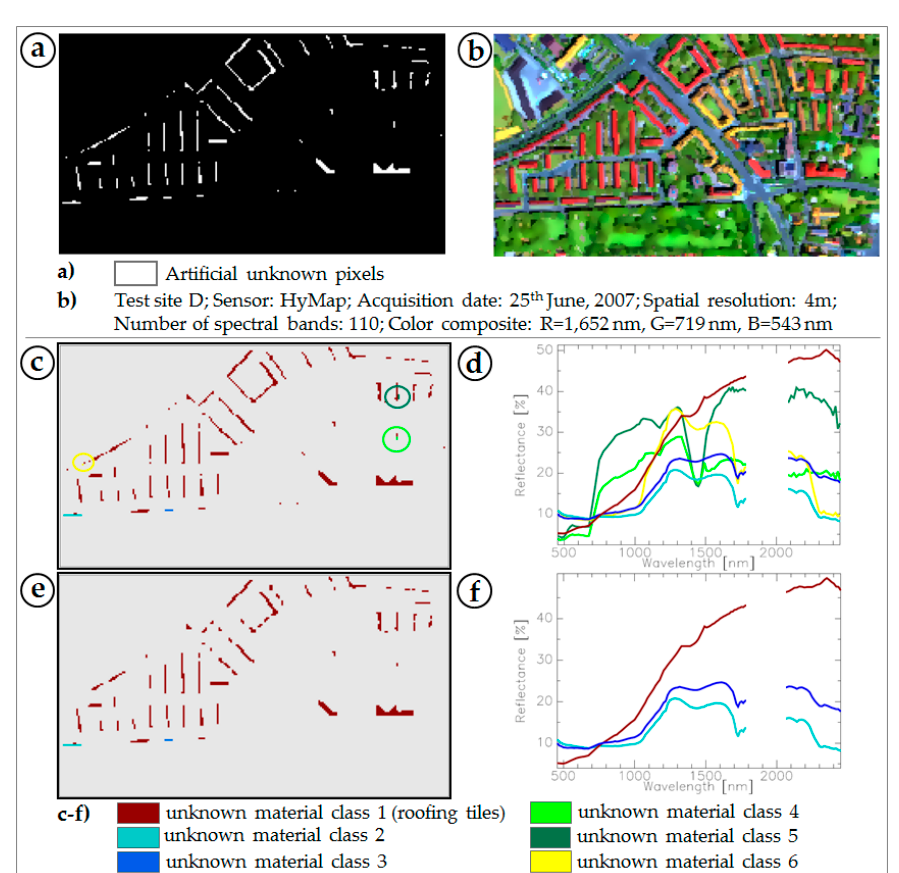
Figure 6. Extraction of unknown artificial material classes from the ( a ) mask of unknown artificial pixels determined from the ( b ) image data of test site D with a BSL setting without roofing tiles and a dissimilarity threshold of 1%. Unknown artificial pixels are subject to ( c ) spatial and spectral clustering to identify spectral mixtures from ( d ) mean unknown class reflectance, accompanied by ( e ) post-processing to delete unknown material classes of remaining mixed pixels to result in an ( f ) scene-specific spectral library of unknown artificial material classes.